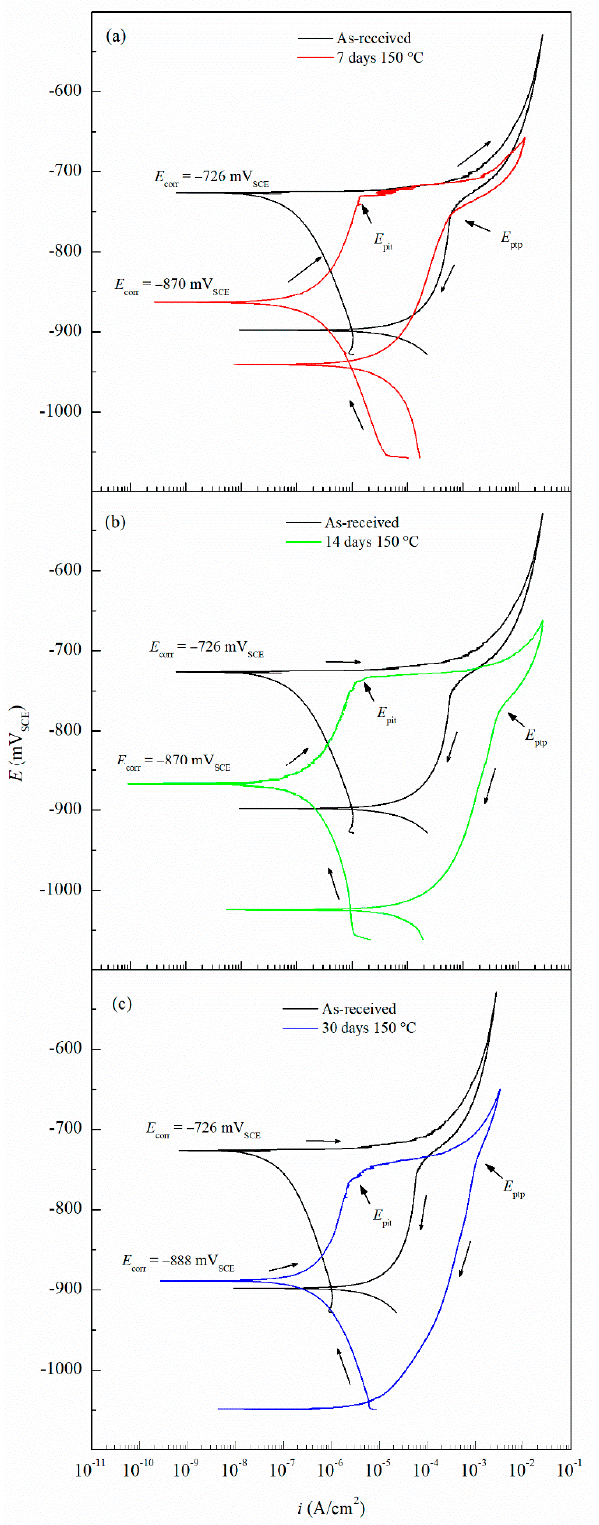
Figure 4. Cyclic potentiodynamic polarization (CPP) curves for AA5083 as-received and sensitized at 150 °C for ( a ) 7 days, ( b ) 14 days and ( c ) 30 days. E pit represents the pitting potential and E ptp represents pitting transition potential.